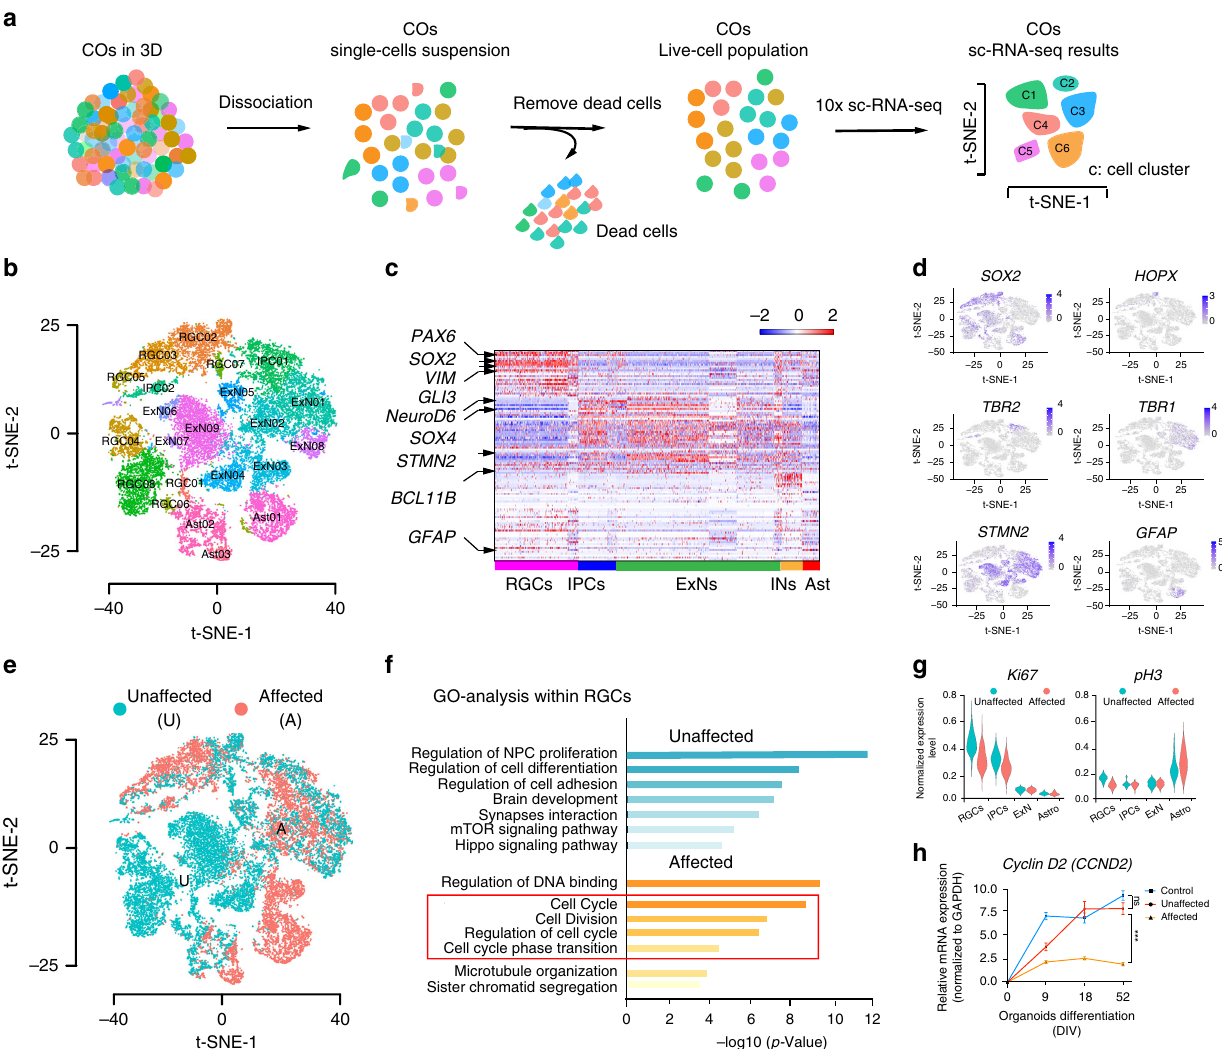
Fig. 4 sc-RNA-seq suggests cell cycle defects in radial glial cells from affected individuals. a Experimental work fl ow for sc-RNA-seq. b t-SNE-plot showed four major cell clusters and 23 detailed cell clusters in COs at div 52; RGC: Radial Glia Cells (with 8 sub clusters); Neurons, including both ExN: Excitatory Neuron (with 9 sub clusters) and INs: Inhibitory Neurons; IPC: Intermediate Progenitor Cells (with 2 sub clusters); Ast: astrocytes (with 3 sub clusters). c Heatmap for the four major cell clusters at div 52. Expression of PAX6 , SOX2 , VIM and GLI3 highlighted to mark RGCs; NEUROD6 and SOX4 mark IPCs; STMN2 and BCL11B mark ExNs and GFAP marks Asts. RPKM was used to calculate expression. d t-SNE plot shows the expression of marker genes in different cell clusters. SOX2 marks RGCs; HOPX marks oRGs; TBR2 marks IPCs; STMN2 and TBR2 mark ExNs; GFAP marks Ast. e t-SNE plot cell cluster distribution. f GO-functional enrichment analysis with differential expression genes (DEGs) highlights cell cycle related pathway in affected COs Log transformed p value was used to measure signi fi cance, the signi fi cance cutoff was set for p < 0.05. Unaffected: U1 + U2; Affected: A1 + A2 g Violin- plot represents the expression of KI67 and pH3 expression in the major cell clusters of unaffected and affected samples. h RT-qPCR shows a reduction of Cyclin D2 ( CCND2 ) expression in affected COs. COs generated from affected and unaffected iPSCs harvested at div 9, 18 and 52 for RNA, following qPCR; Levels of CCND2 was measured. GAPDH was used as control; Relative expression was normalized to cDN A derived from an unrelated control. n = 12 ( n represents 3 independent biological replicates generated from iPSCs at different passages (<25), and four times technical replicates for each of the independent biological replicate), ** p < 0.01. Error bars: ± SD. Data are presented as mean values ± SD. Source data are provided as a Source Data fi